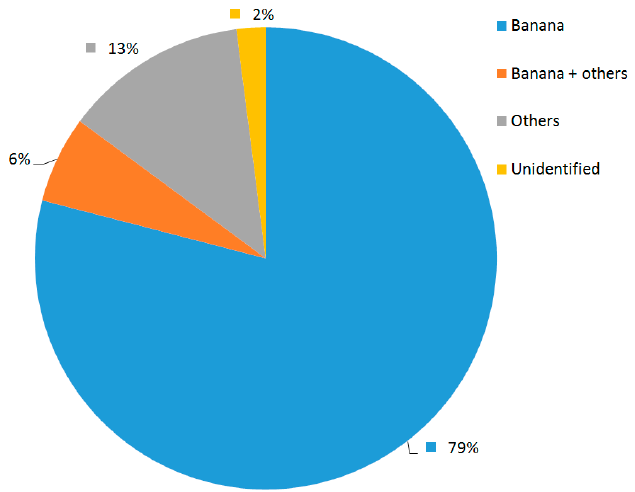
Figure 1. Identification of the aroma from banana brandy according to sensory evaluation.